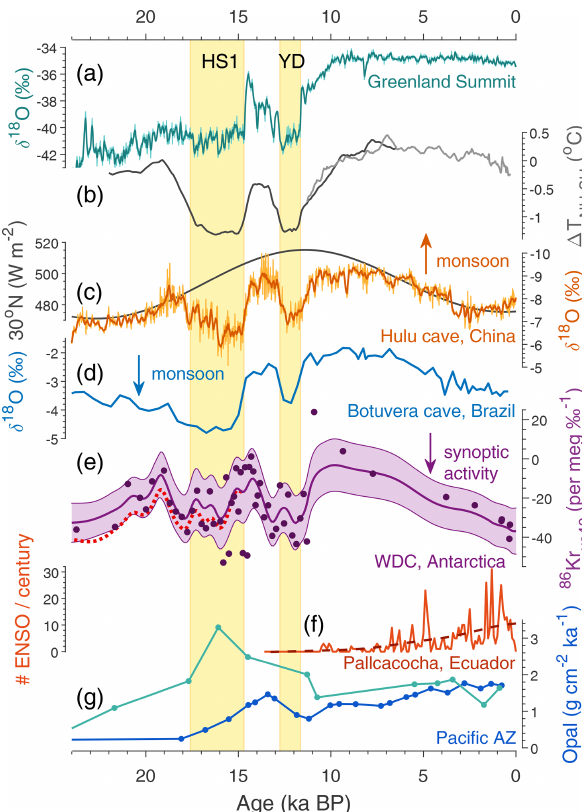
Figure 7. Climate records through the last deglaciation with the Heinrich Stadial 1 (HS1) and Younger Dryas (YD) North Atlantic cold periods marked in yellow. (a) Greenland Summit ice core sta- ble water isotope ratio δ 18 O, here the average of the GISP2 and GRIP ice cores (Grootes et al., 1993). (b) Hemispheric tempera- ture difference (McGee et al., 2014) based on global proxy compi- lations for the Holocene (Marcott et al., 2013) and last deglaciation (Shakun et al., 2012). (c) Speleothem calcite δ 18 O from Hulu and Dongge caves, China, as a proxy for East Asian summer monsoon strength (Dykoski et al., 2005; Wang et al., 2001). Superimposed is summer solstice (21 June) insolation at 30 ◦ N. (d) Speleothem cal- cite δ 18 O from Botuvera cave, southern Brazil, as a proxy for South American summer monsoon strength (Cruz et al., 2005; Wang et al., 2007). (e) Kr-86 excess record from WAIS Divide (this study), corrected for gas loss and thermal fractionation (Appendix A). The center line and shaded envelope show the mean and ± 1 σ uncer- tainty interval of a 10000-iteration Monte Carlo smoothing ex- ercise (see text). The dotted red line equals the center line with a correction for elevation change applied (Appendix A) using a simulated elevation history (Golledge et al., 2014). (f) Number of El Niño events per century from laminations in sediments from La- guna Pallcacocha, Ecuador (Moy et al., 2002). (g) Th-normalized opal flux in the Pacific Antarctic zone (south of the polar front) from cores NBP9802-6PC1 (turquoise; 169.98 ◦ W, 61.88 ◦ S) and PS75/072-4 (blue; 151.22 ◦ W, 57.56 ◦ S), reflecting local productiv- ity and (wind-driven) upwelling (Chase et al., 2003; Studer et al., 2015). All water isotope data in this figure are on the Vienna Stan- dard Mean Ocean Water (V-SMOW) scale. Arrows show the direc- tion of increased monsoon strength and synoptic